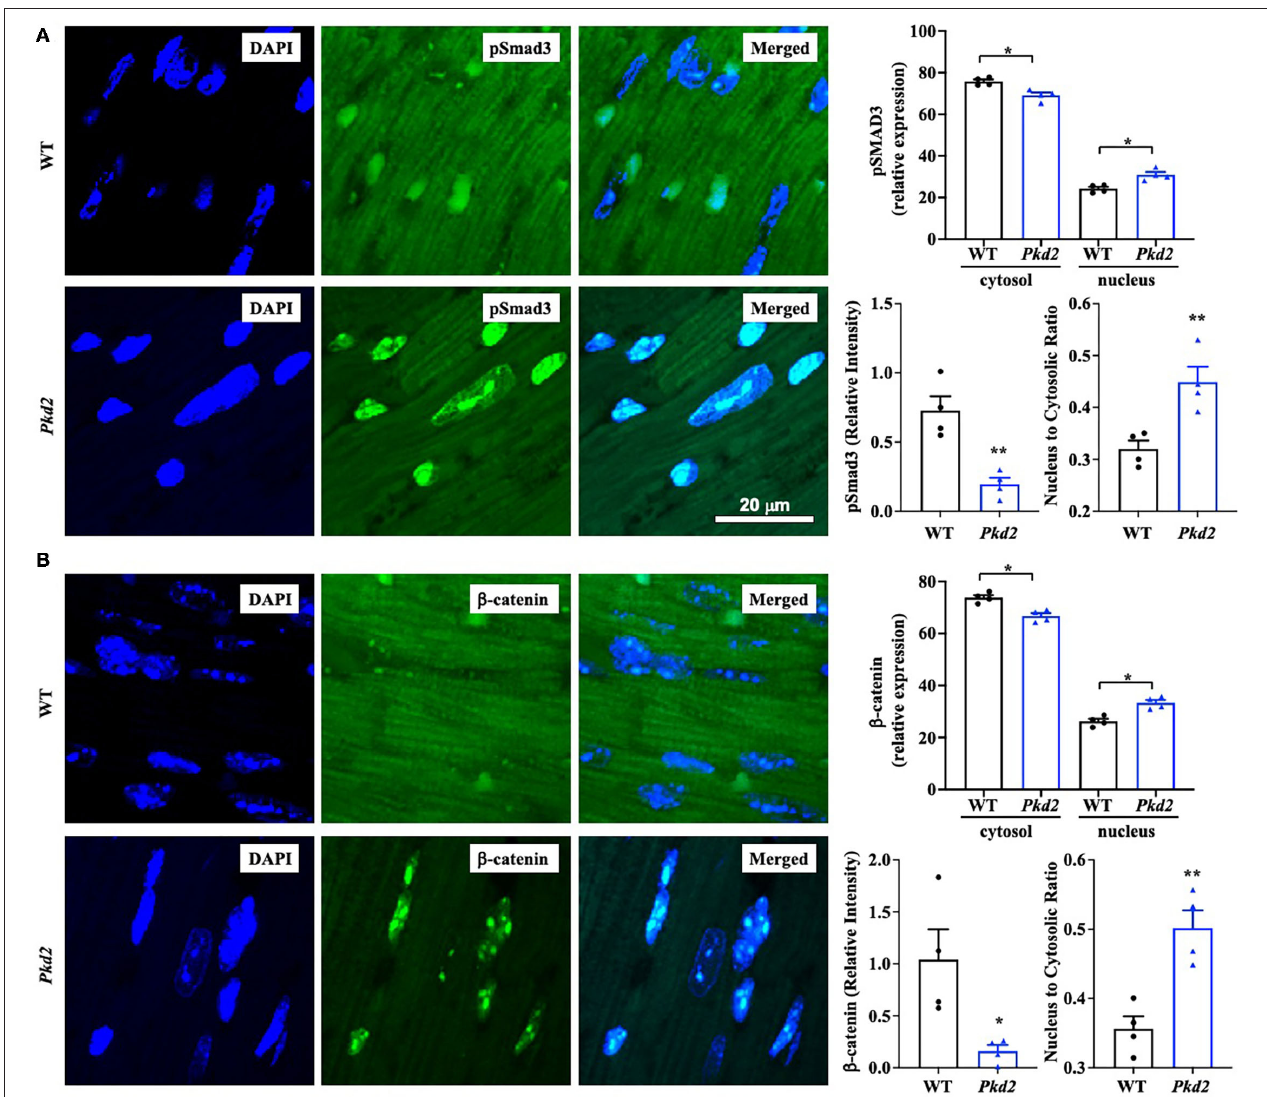
FIGURE 9 | The hearts from Pkd2 -KO mice are characterized with a significant increase in nuclear localization of pSMAD3 and β -catenin. (A,B) Immunofluorescence staining of pSmad3 (A) or β -catenin (B) revealed a significant increase in nuclear localization and nucleus to cytoplasm ratio of pSmad3 or β -catenin in Pkd2 -KO ( Pkd2 ) compared to wild-type (WT) hearts. N = 4 mice for each group. A total of 8 independent slides were used for each mouse. * p < 0.05; ** p <